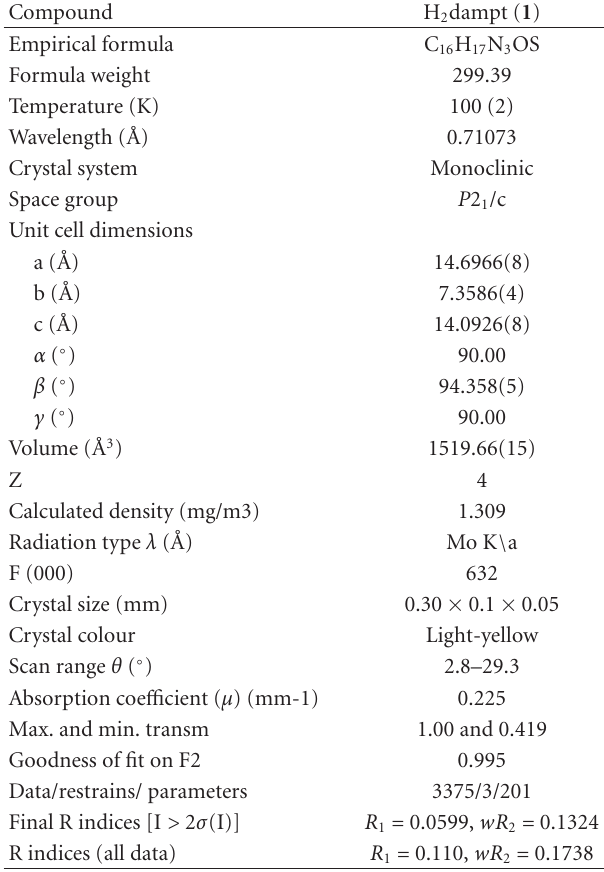
Table 1: Summary of crystal data and structure refinement parameters for ligand